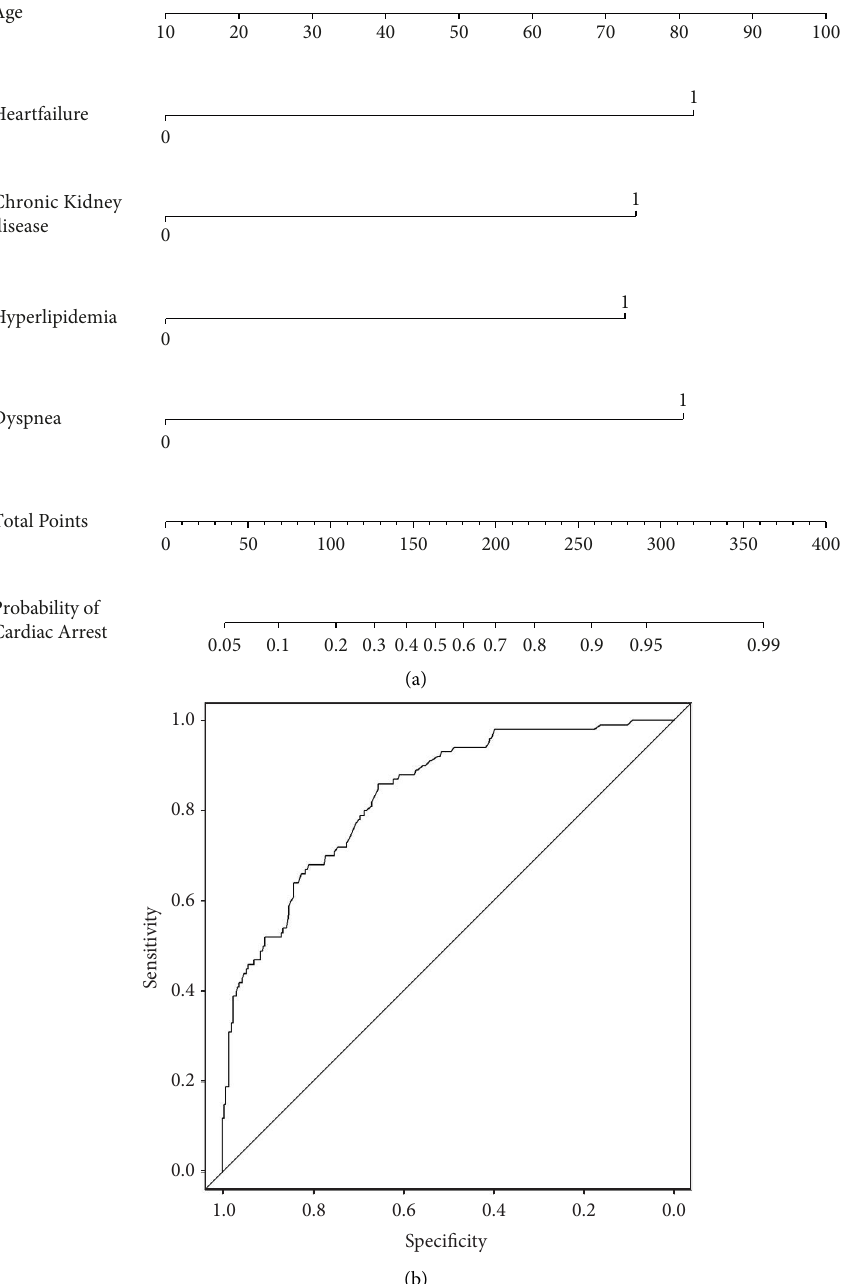
Figure 2: (a) Nomograph of the QSM-CA model, we assign values to each of the variables (Table 3) and total them as a predictive risk score. (b) ROC of the model, the AUC (C index) of the area under the ROC curve was